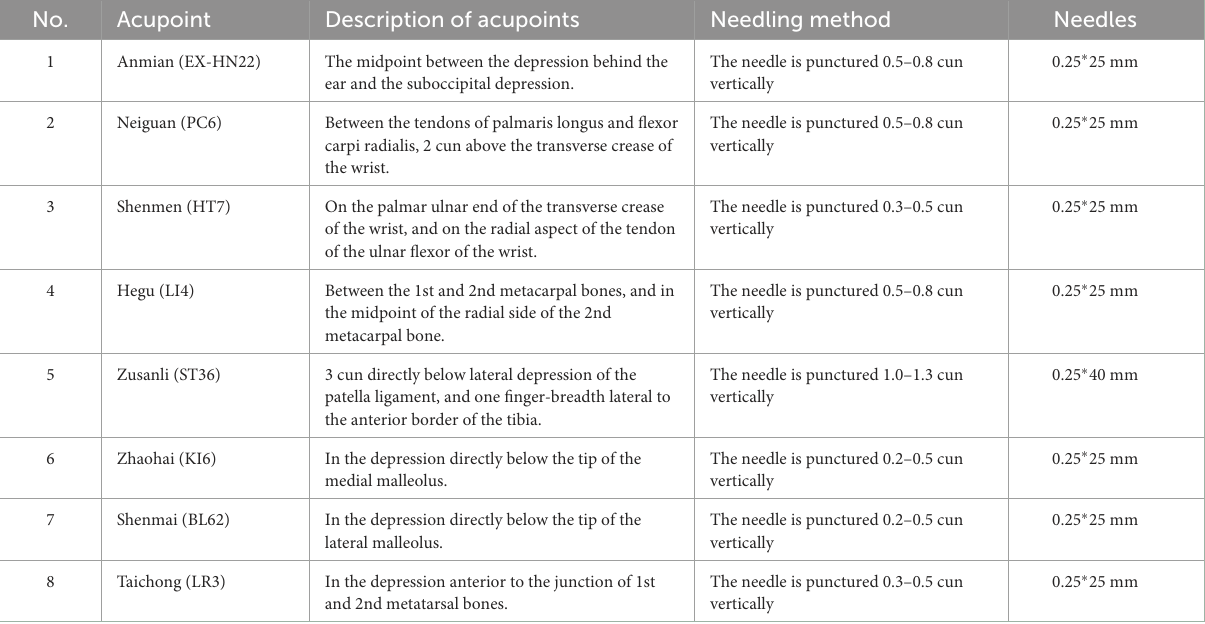
TABLE 1 Description of each acupoint and acupuncture